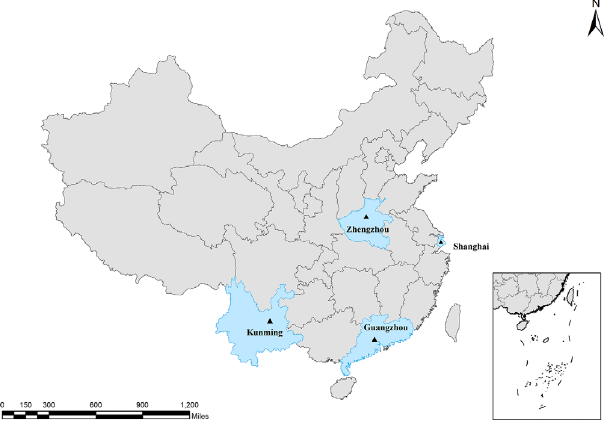
Figure 1. Sampling locations of the laboratory rodents in China. N : Sample collection